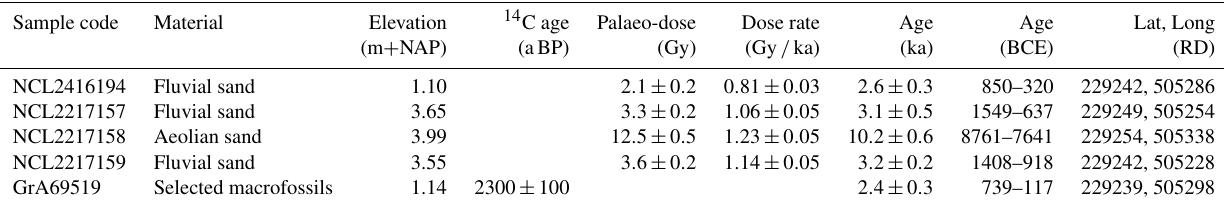
Table 2. OSL and 14 C dating results from Palaeochannel X . Locations are indicated in Fig. 1c, d and Fig. 4c. Sample